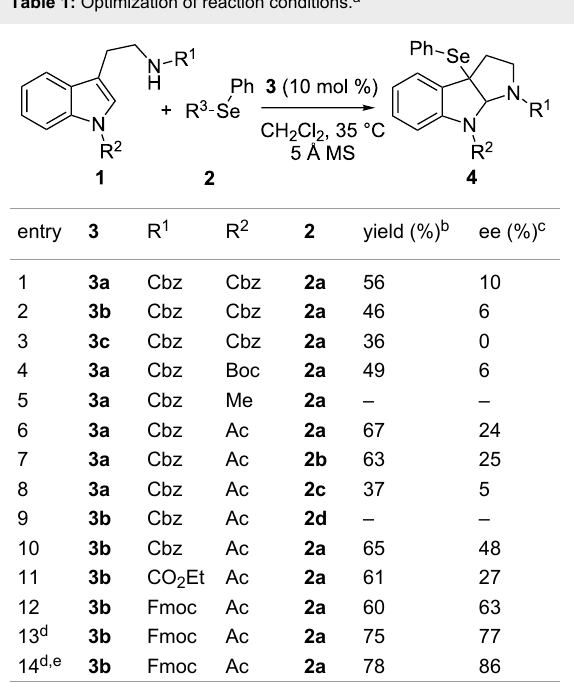
Table 1: Optimization of reaction conditions. a